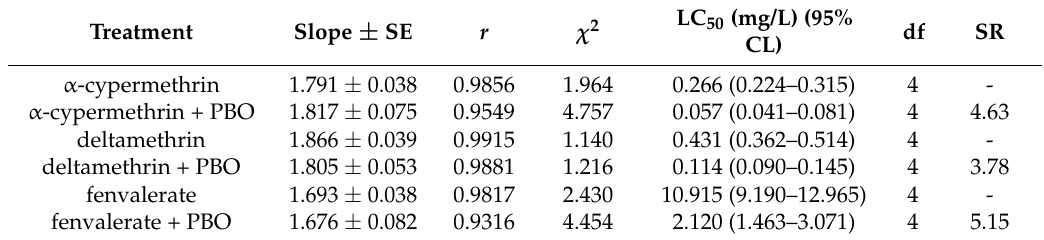
Table 1. Effect of PBO on the toxicity of pyrethroids to fourth instar S. exigua larvae.